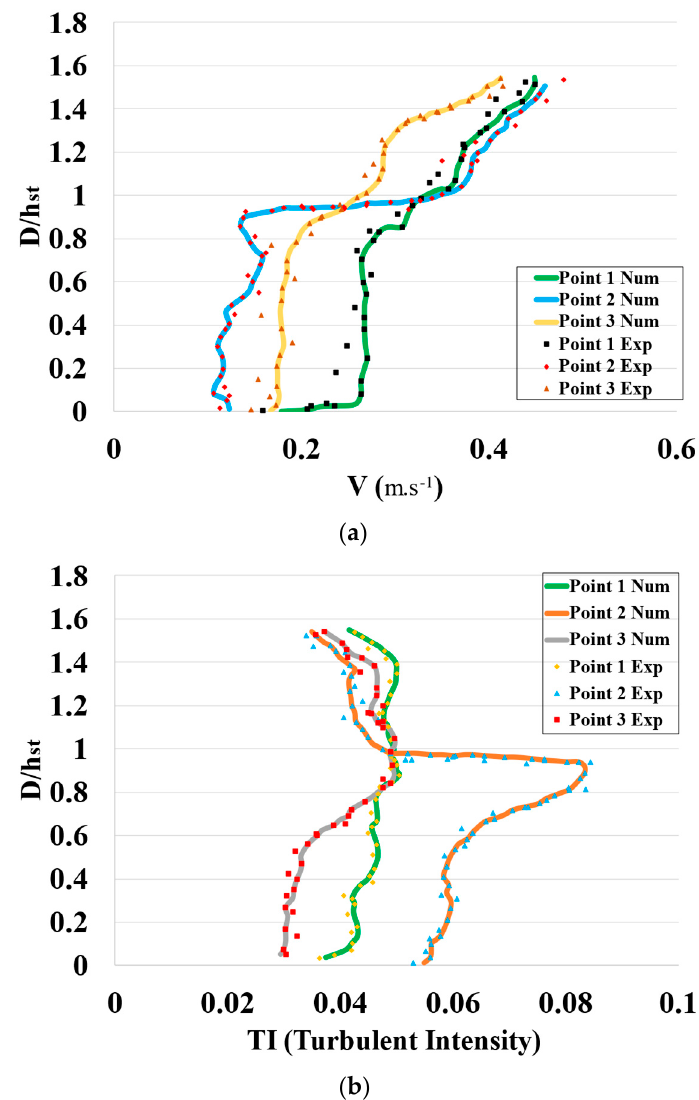
Figure 2. Comparison between the experimental results of [33] and the computed results of ( a ) velocity profiles and ( b ) turbulence intensity profiles.